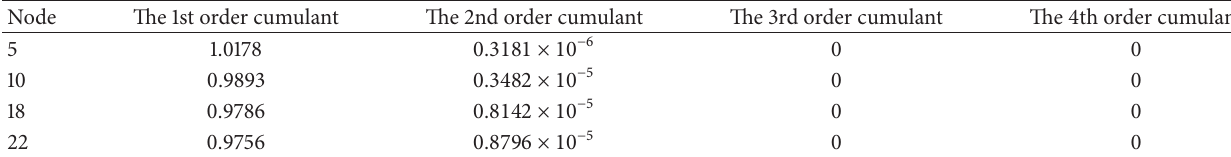
Table 2: Moment of bus voltage in case 1.